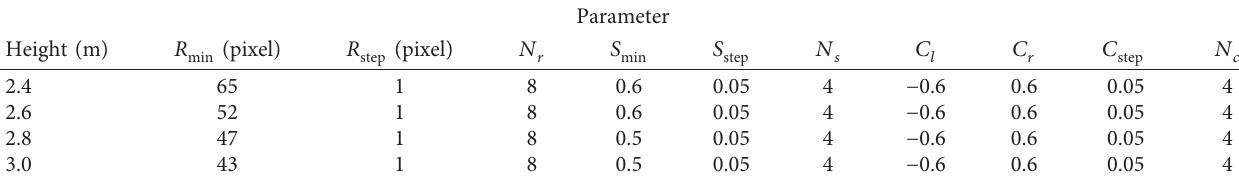
Table 3: The prior transformation parameters for the inner idler outer edge detection.